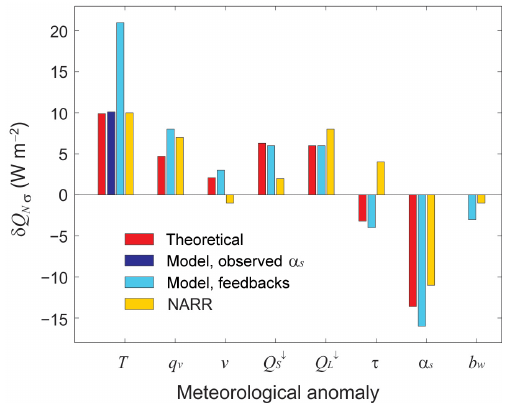
Figure 9. Net energy sensitivity to a 1 σ perturbation in different meteorological variables: comparison of theoretical, in situ numeri- cal model, and NARR-based